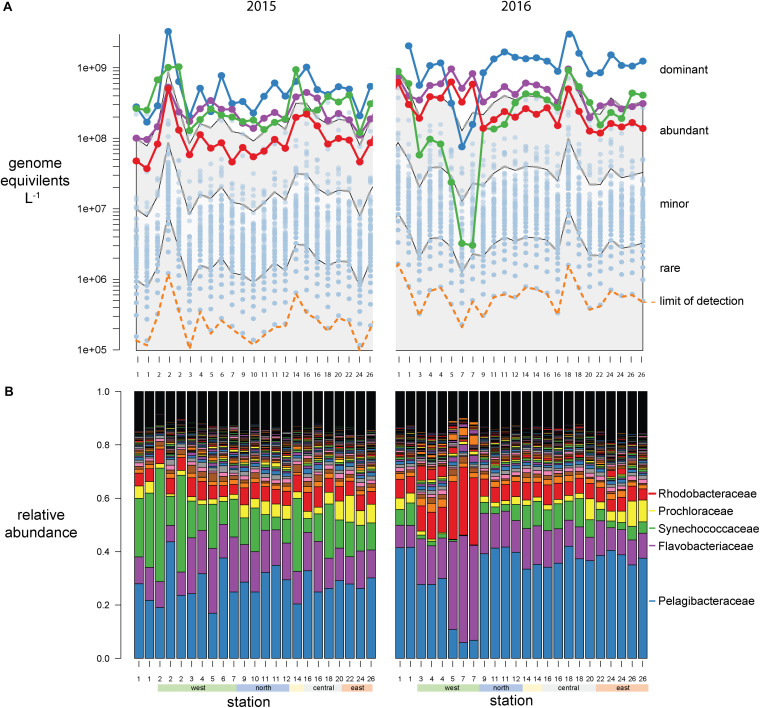
Galápagos marine microbiome composition across the archipelago based on recA recovery and binned at the family level. (A) Volumetric abundances of all bacterial families. The top 5 families are colored as follows Pelagibacteracea, blue; Flavobacteriaceae, purple; cyanobacteria, green; Rhodobacteraceae, red. The remaining 477 families are plotted as semitransparent blue circles. The distribution of families was categorized into four groups based on their volumetric abundances: dominant, abundant, minor, and rare, and these bins are outlined by the gray and white shading. (B) Relative abundances (percent of total site recA sequences) of all bacterial families across the sampling stations.